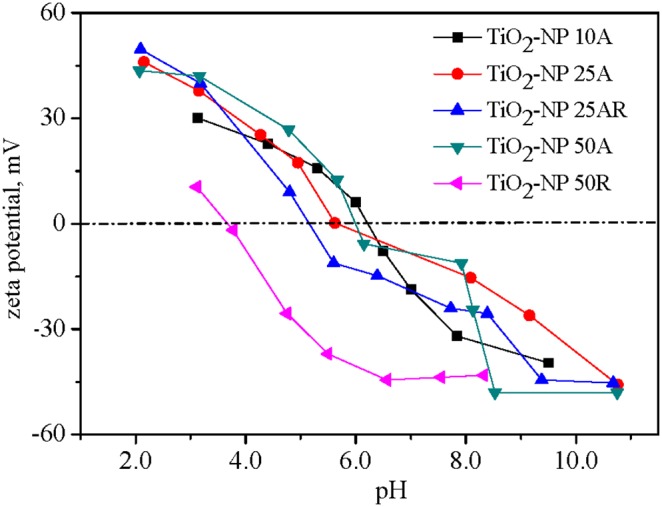
Changes of zeta potentials of the TiO2 NPs against a solution pH.